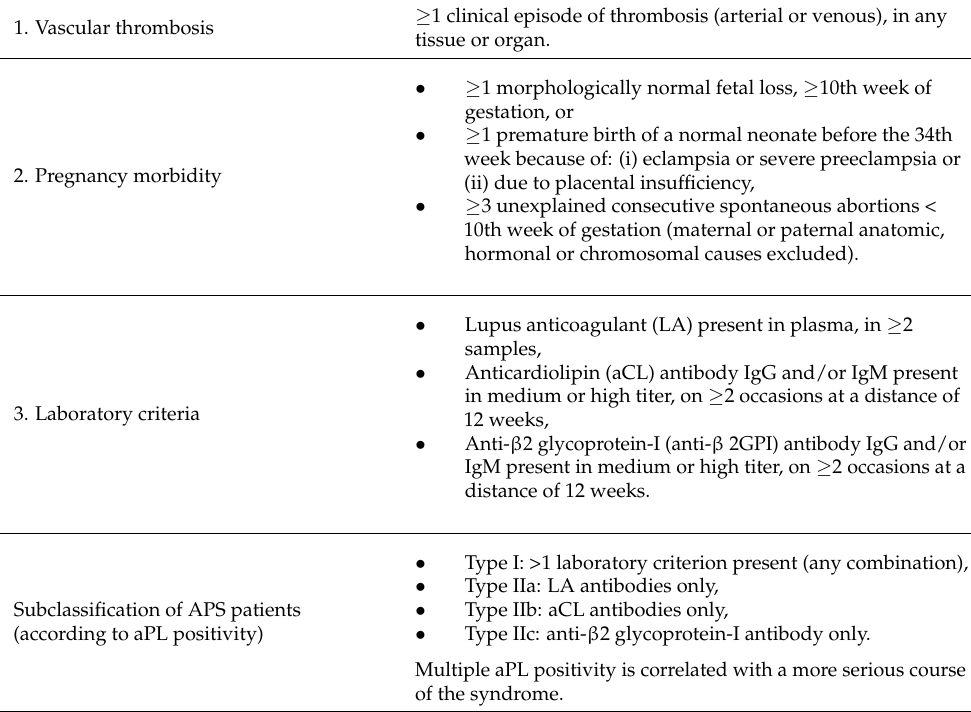
Table 1. Sydney criteria for